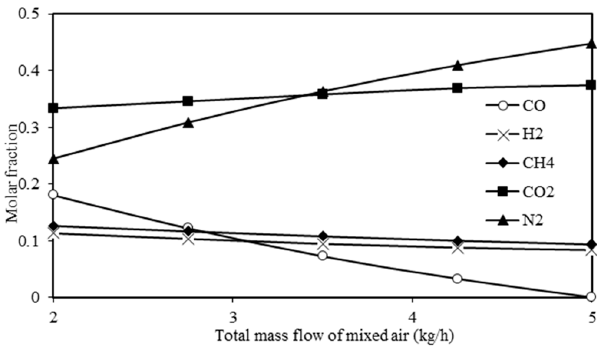
Figure 4. Composition of gas leaving the combustor.